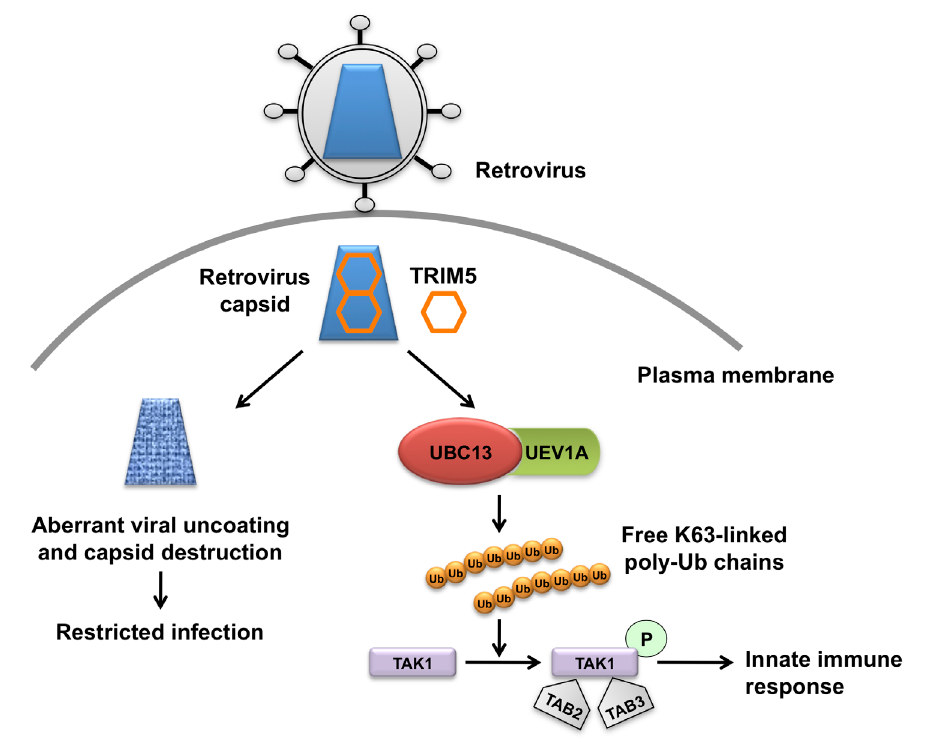
Figure 1. The dual role of TRIM5α in retrovir us infection. The retrovirus capsid is engaged by TRIM5 α in the cytoplasm of the infected cell and forms a hexagonal lattice on top of the capsid. This leads to aberrant uncoating of the capsid and blocks retrovirus infection. Concomitantly, TRIM5α binding to capsid triggers its E3 ligase activity , and in concert with the E2 ubiquitin (Ub)-conjugating enzyme complex UBC13–UEV1A generates free lysine 63 (K63)- linked Ub chains, which in turn are catalysts in the autophosphorylation (indicated as a letter P in the green circle) of the TAK1 complex (includes TAK1, TAB2, and TAB3). Activation of the TAK1 complex by autophosphorylation results in the induction and expression of NF- κ B- and MAPK - responsive inflammatory genes, thereby leading to an innate immune response in the infected